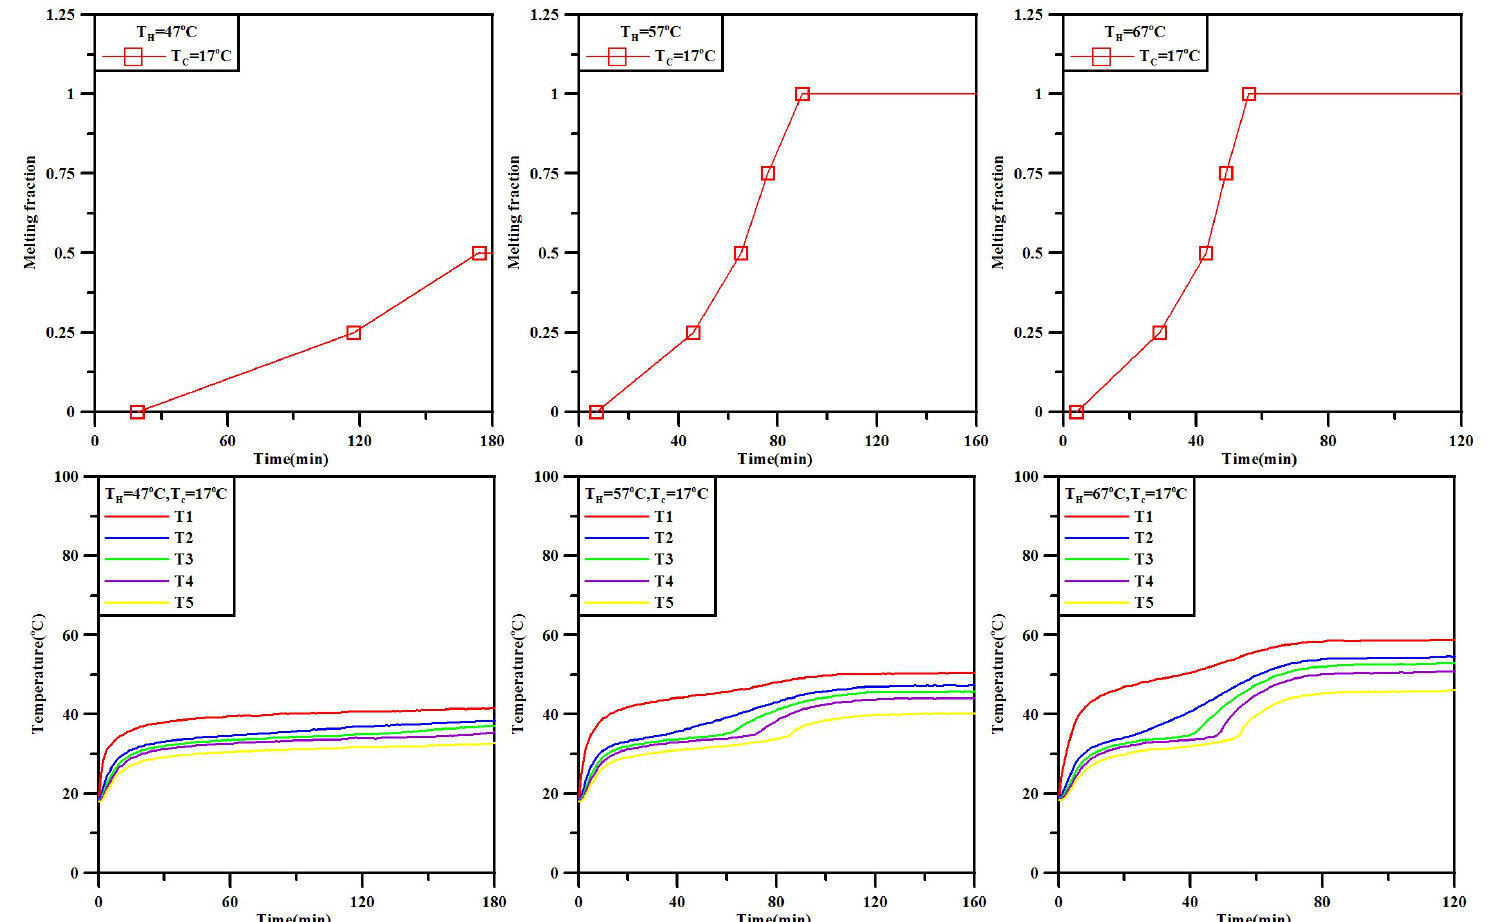
= 17 ◦ C and various T C H